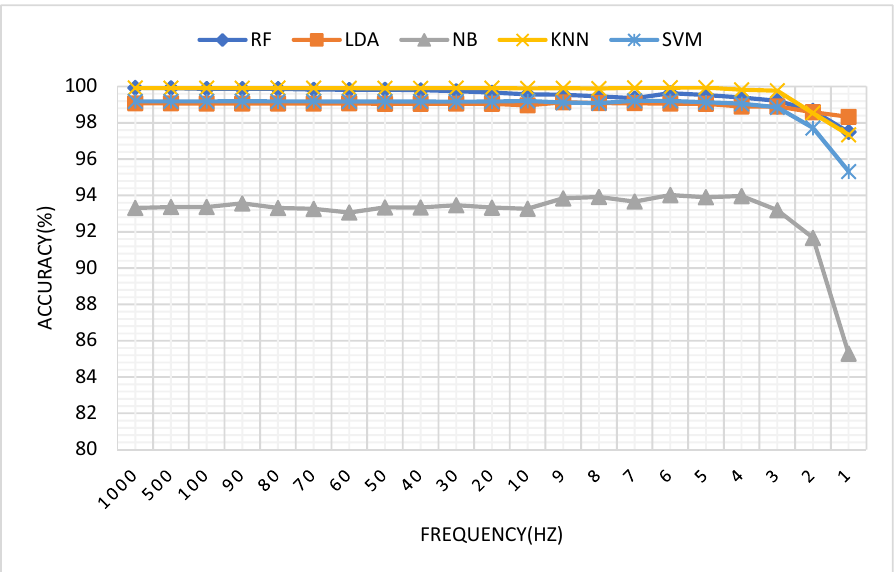
Figure 7. The tendency of classification accuracy (%) along with the decreasing of sampling frequency.